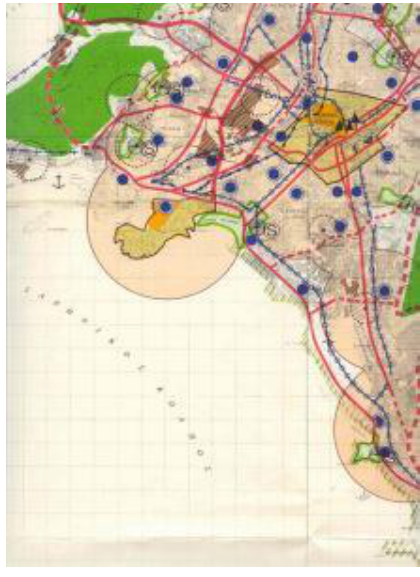
Fig 2. Aspect of the Athens Regulatory Plan. Ministry of Urban Planning, Ekistics and Environment